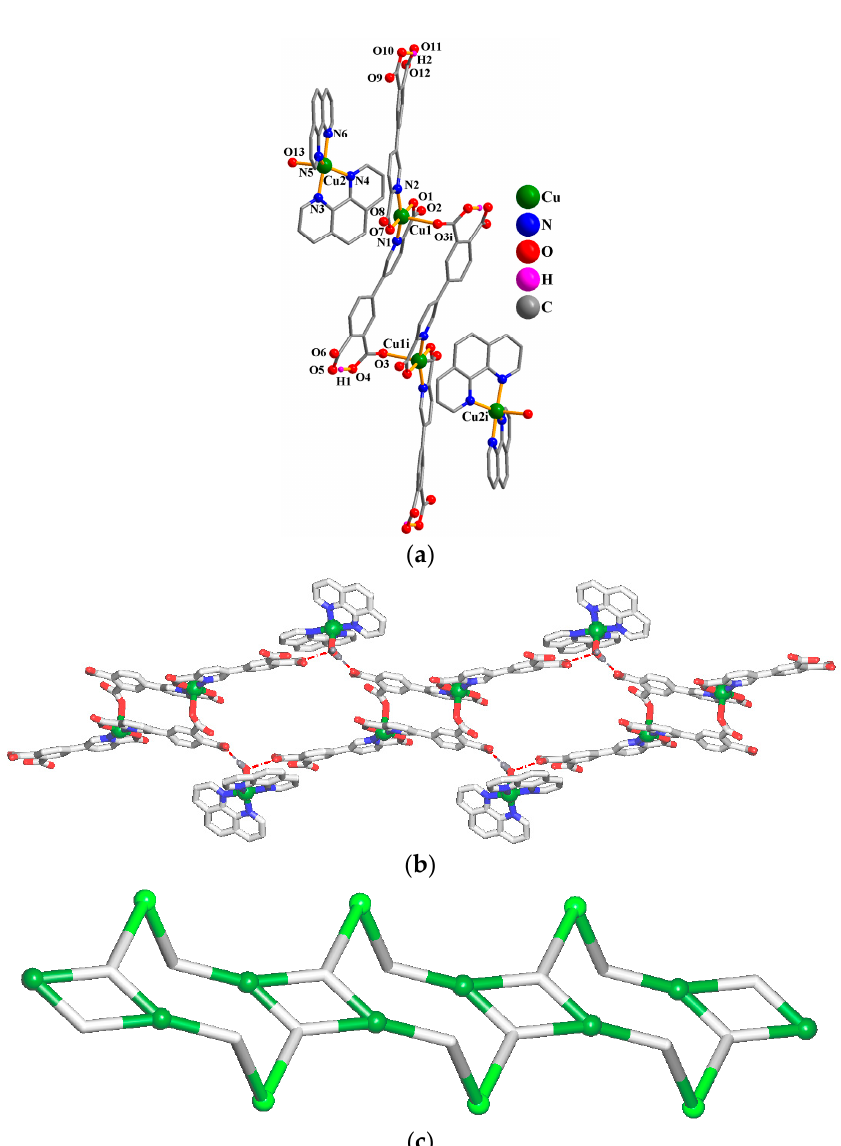
values for related Cu(II) derivatives [31,40–42]. In 2 , the Hdppa 2 − blocks act as a terminal monodentate ligand (mode III, Scheme 2) or as a µ-linker (mode II), having the corresponding dihedral angles of 9.64° or 19.24° between pyridyl and phenyl rings. In the anion, two µ-Hdppa 2 − between pyridyl and phenyl rings. In the anion, two µ -Hdppa 2 − moieties link two adjacent Cu1 moieties link two adjacent Cu1 atoms to form a Cu 2 unit with a Cu ∙∙∙ Cu separation of 9.375(2) Å atoms to form a Cu 2 unit with a Cu · · · Cu separation of 9.375(2) Å (Figure 2a). The dicopper(II) (Figure 2a). The dicopper(II) [Cu 2 (µ-Hdppa) 2 (µ-Hdppa) 2 ] 4 − anions and monocopper [Cu 2 ( µ -Hdppa) 2 ( µ -Hdppa) 2 ] 4 − anions and monocopper [Cu(H 2 O)(phen) 2 ] 2+ cations are arranged [Cu(H 2 O)(phen) 2 ] 2+ cations are arranged into the intricate 1D H-bonded double chains (Figure 2b). into the intricate 1D H-bonded double chains (Figure 2b). After simplification, such 1D chains can be After simplification, such 1D chains can be topologically defined as a uninodal 3-connected topologically defined as a uninodal 3-connected underlying net (Figure 2c) with the SP 1-periodic net underlying net (Figure 2c) with the SP 1-periodic net (4,4)(0,2) topology and the point symbol of (4,4)(0,2) topology and the point symbol of (4 2 .6). (4 2 .6).